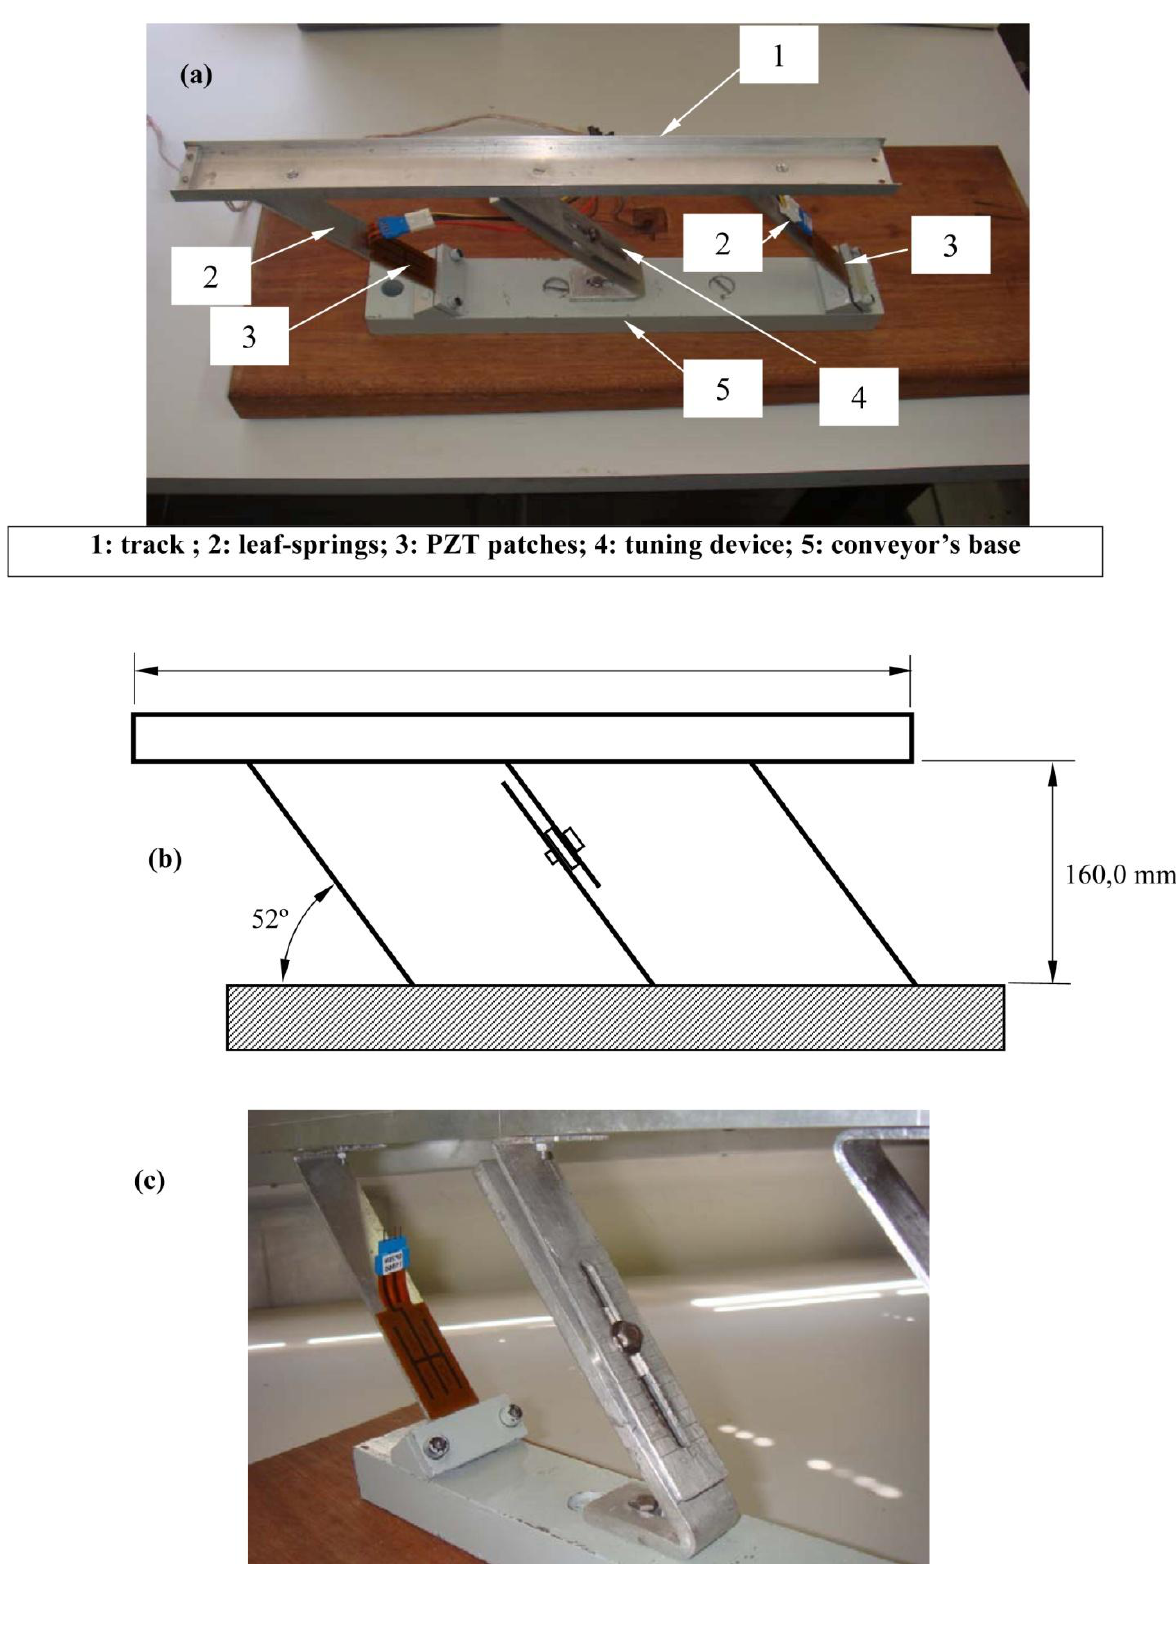
Figure 3. ( a ) Photograph of the piezoelectric vibratory feeder; ( b ) Main dimensions of the prototype; ( c ) detail of the tuning